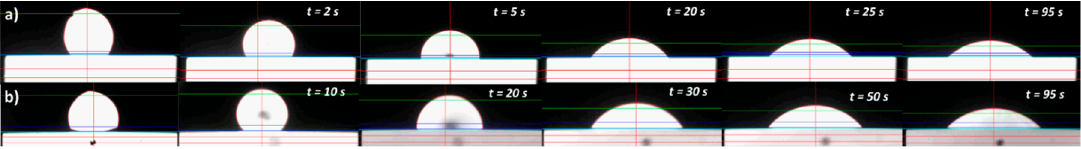
Figure 3. Time sequence images recorded during the wetting experiments performed by sessile drop method at T = 1450 °C under an Ar atmosphere; ( a ) Si-8at%Ti/GC and ( b ) Si-24at%Ti/GC.